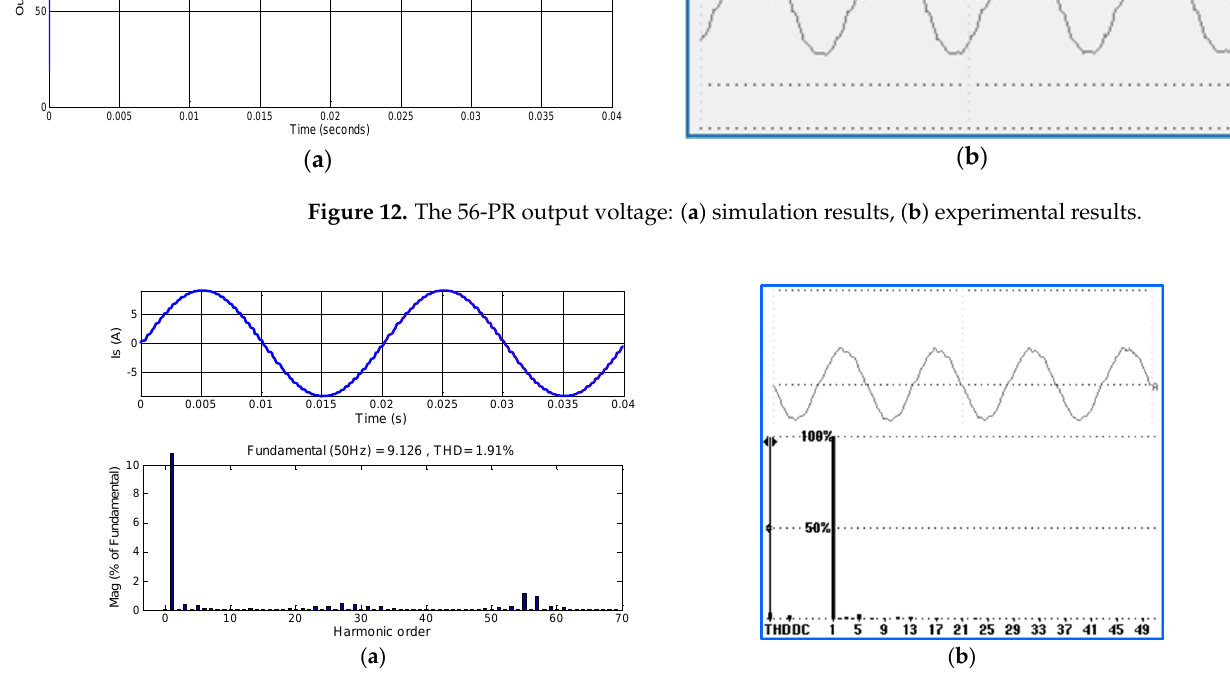
Figure 13. The input line current and its harmonic spectrum of the proposed 56-PR: ( a ) simulation results, ( b ) experimental results.